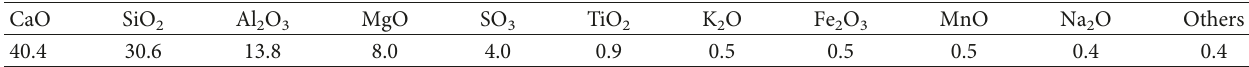
Table 2: Chemical compositions of GGBS (%).